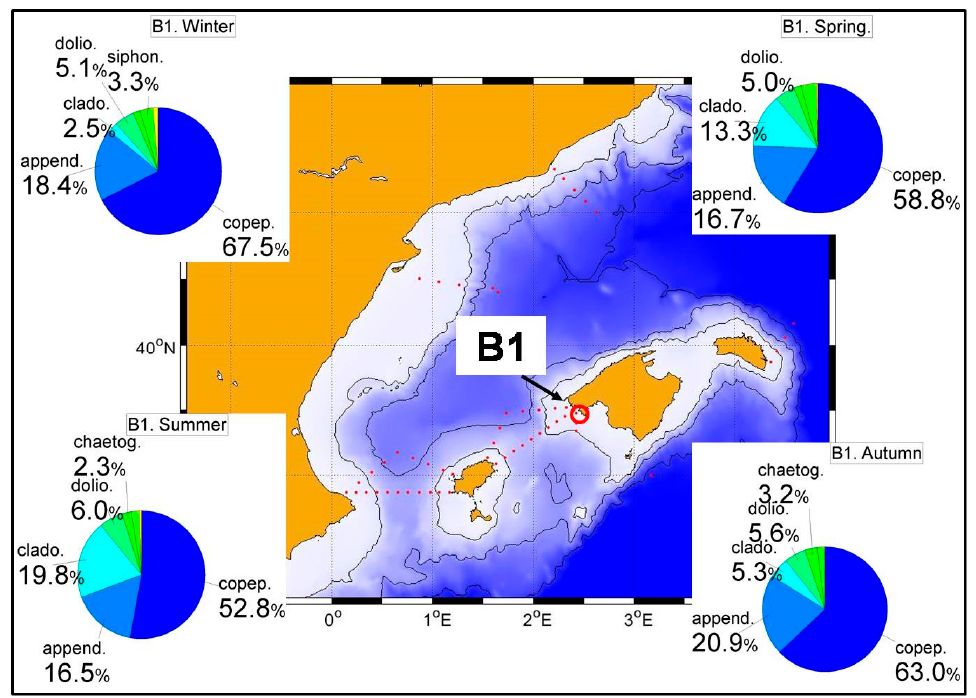
Figure 11. Relative abundances expressed as percentages for broad groups of the meso-zooplankton at the station B1 in Palma transect. This figure has been done using data in Fernandez de Puelles et al. [43].